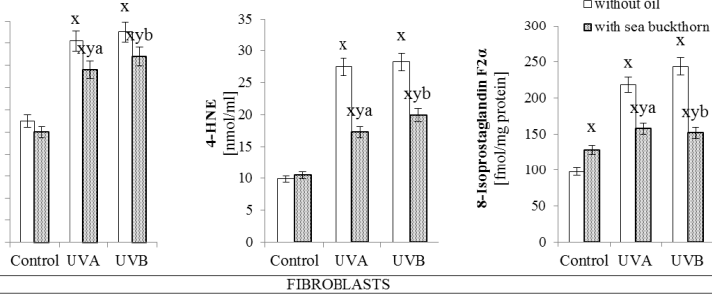
Figure 4. The activity of phospholipase A2 and level of lipid peroxidation products (4-HNE and 8-Isoprostaglandin F2 α ) in keratinocytes and fibroblasts after exposure to UVA (30 J/cm 2 and 20 J/cm 2 ) and UVB radiation (60 mJ/cm 2 and 200 mJ/cm 2 , respectively) and sea buckthorn seeds oil (500 ng/mL) treatment. Mean values ± SD of five independent experiments are presented. x statistically significant differences vs. control group, p < 0.05; y statistically significant differences between UVA/UVB and oil treated groups vs. oil treated control group, p < 0.05; a statistically significant differences between UVA and oil treated group vs. UVA treated group, p < 0.05; b statistically significant differences between UVB and oil treated group vs. UVB treated group, p <